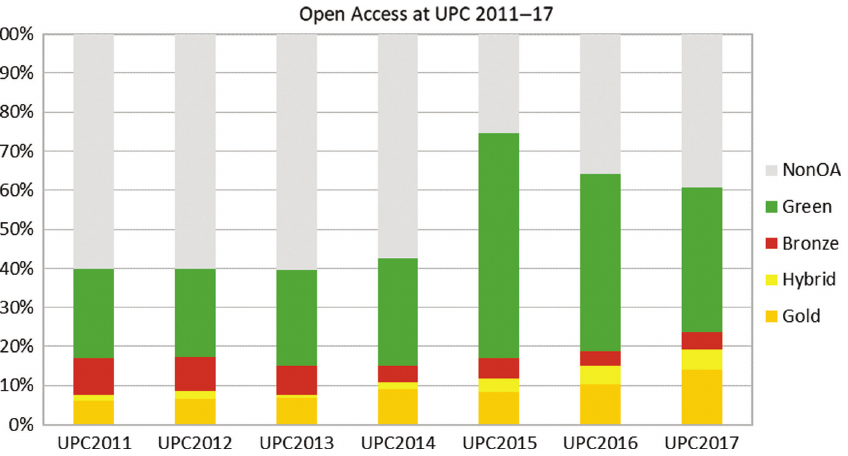
(2018). In our samples we detected five different statutes: non open access (grey), fully open access (gold), hybrid open access (pale yellow), public access (bronze), only available in a repository